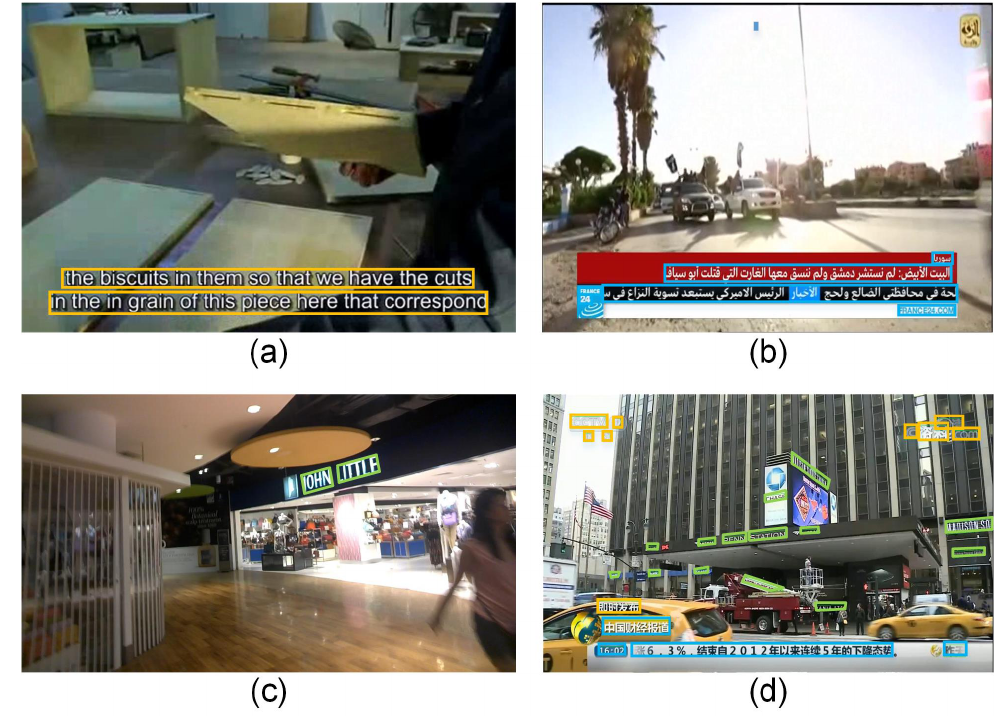
Figure 1. Examples of different text-style categories. ( a ) Overlaid text detection from USTB-VidTEXT [5]. ( b ) Layered text detection from AcTiv [6]. ( c ) Scene text detection from ICDAR2015 [7]. ( d ) The proposed Text3C dataset with all text types, which supports the challenges of text detectors and multidimensional text research for this text-related community. We mark the overlaid, layered, and scene text instances in orange, blue, and green, respectively. Best viewed in